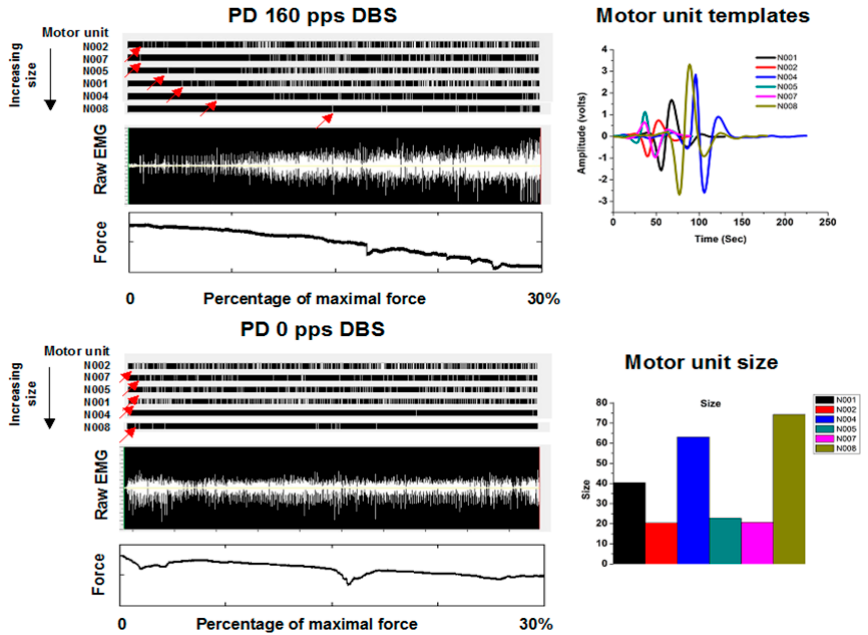
Figure 3. Representative example of raw intramuscular electromyographic (EMG) activities in a subject with Parkinson’s disease under conditions of 160 pulses per second (pps) DBS (therapeutic) and 0 pps DBS. The raw EMG under 160 pps DBS has a stair-step appearance. Each step is associated with recruitment of a larger motor unit. The same six motor units were identified under both conditions and their waveforms and size are shown. The waveform associated with each motor unit is distinct and varies in size from its fellows. The size was determined by measuring the area under the curve. The time of occurrence of a motor unit discharge appears in the raster, with one row for each motor unit. The red arrow indicates onset of activities as the force generated increases progressively. In the 160-pps DBS condition, an orderly recruitment is shown (indicated by red arrows): Consistent with the Henneman Size Principle, smaller units are recruited first, followed by progressively larger motor units. Under the 0-pps DBS condition, the orderly recruitment of motor units is lost and the units are recruited nearly simultaneously. Large motor units are recruited early in the task and at small forces.